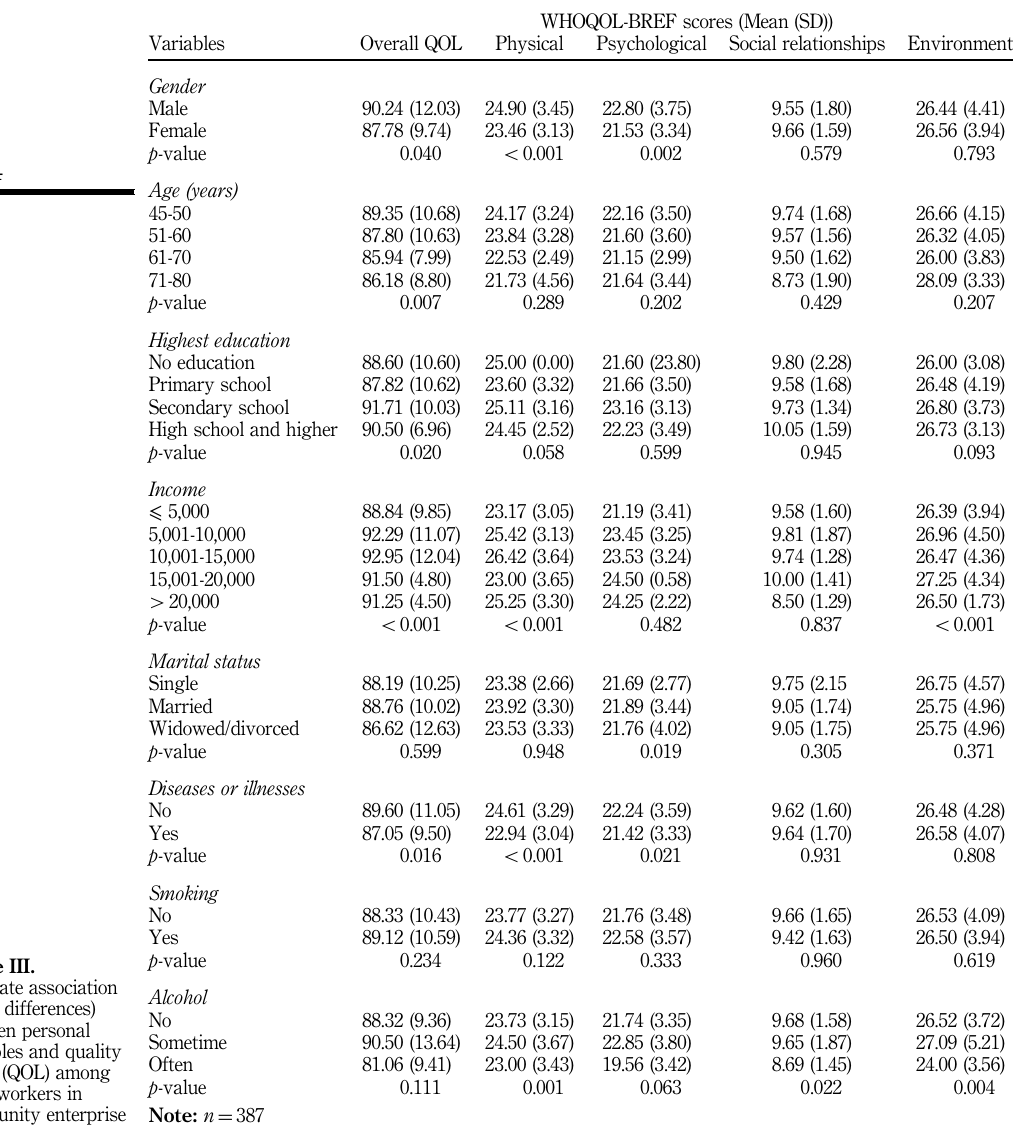
Table III. Bivariate association (mean differences) between personal variables and quality of life (QOL) among older workers in community